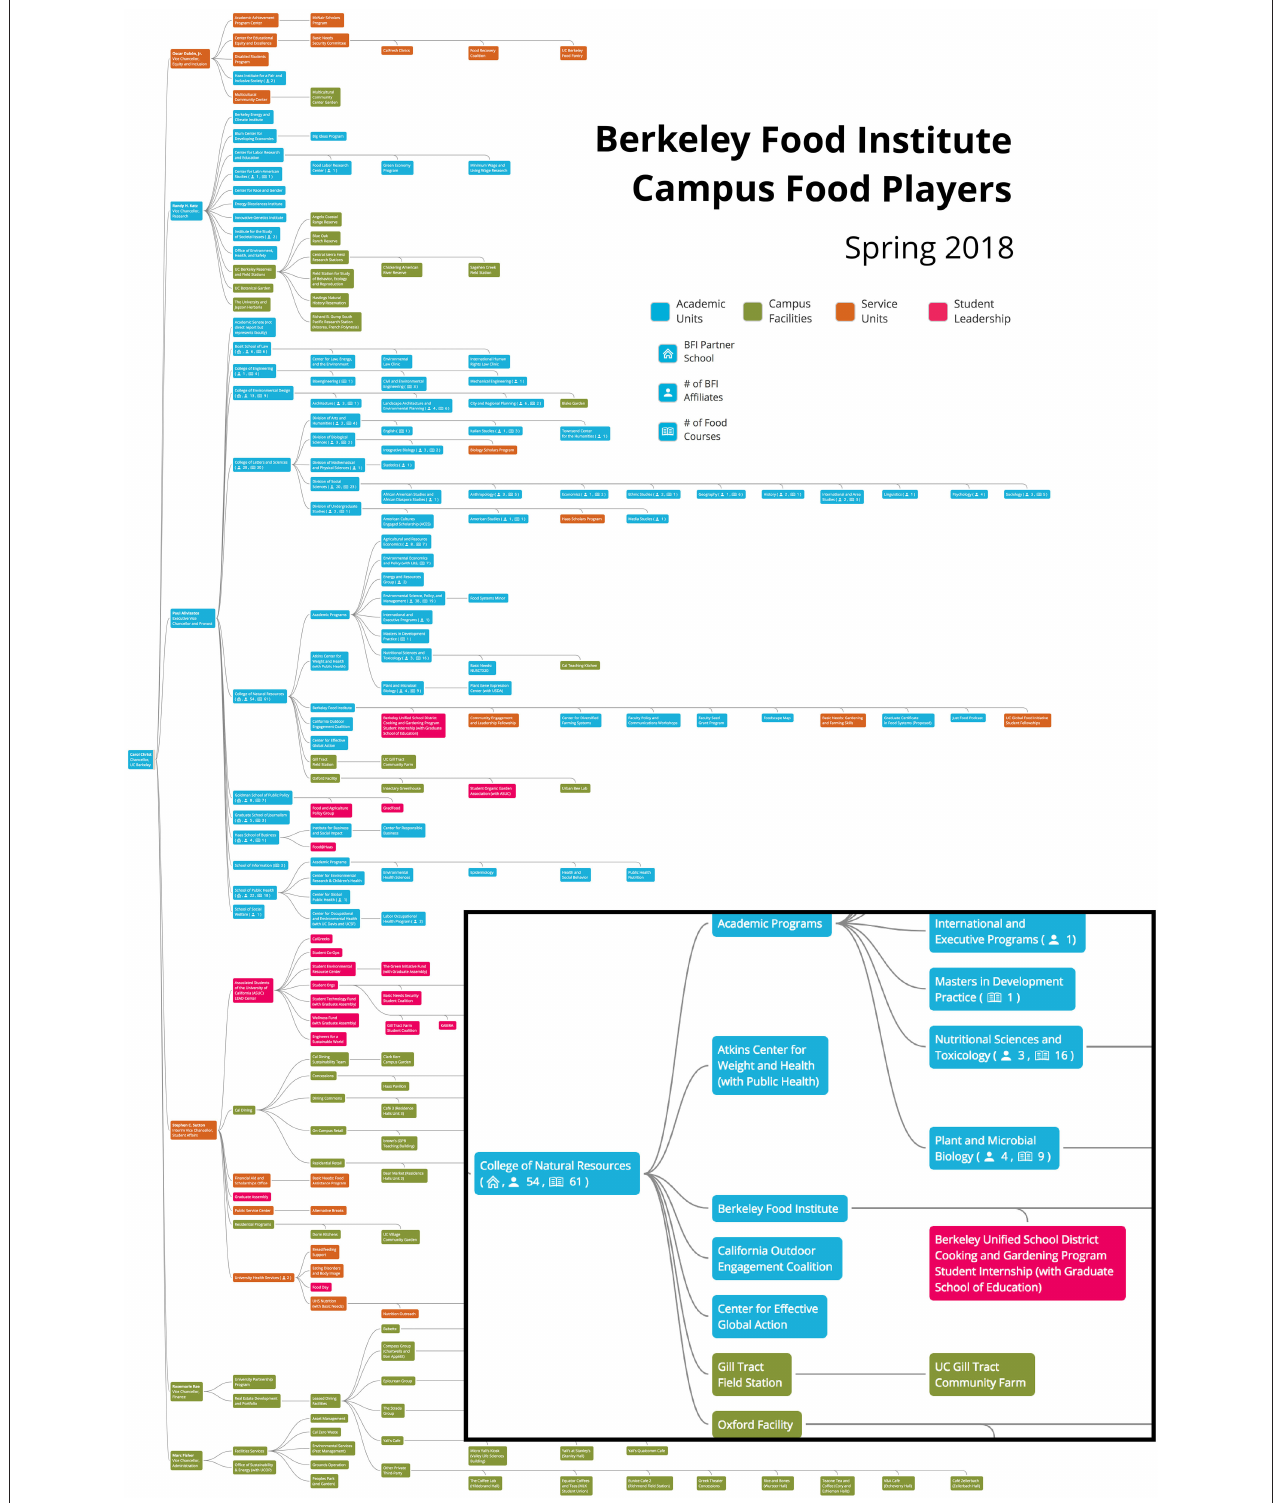
FIGURE 1 | Campus food players, with the animated power map fully expanded. The inset features a detail. In the online map, each tile contains a live link to the unit. See: https://food.berkeley.edu/foodscape/map/. Data collection by Angelina Amezcua, Nadia Barhoum, Rosalie Zdzienicka Fanshel, Melina Packer, Will Payne, Dennis Uyat, and Kara Young. Final visualization by Will